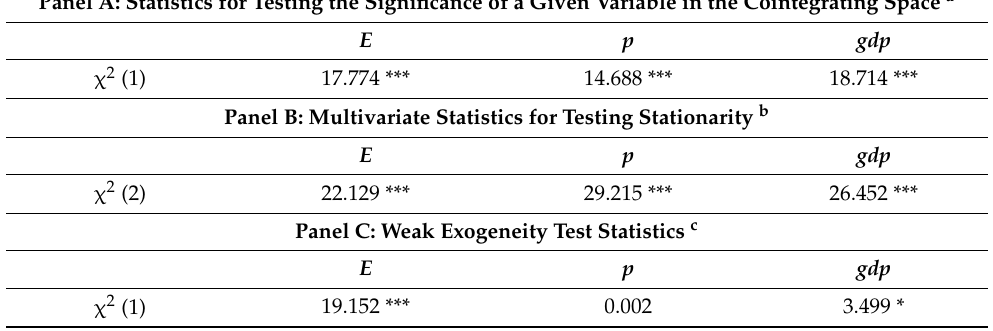
Table 5. The significance, stationarity, and weak exogeneity tests